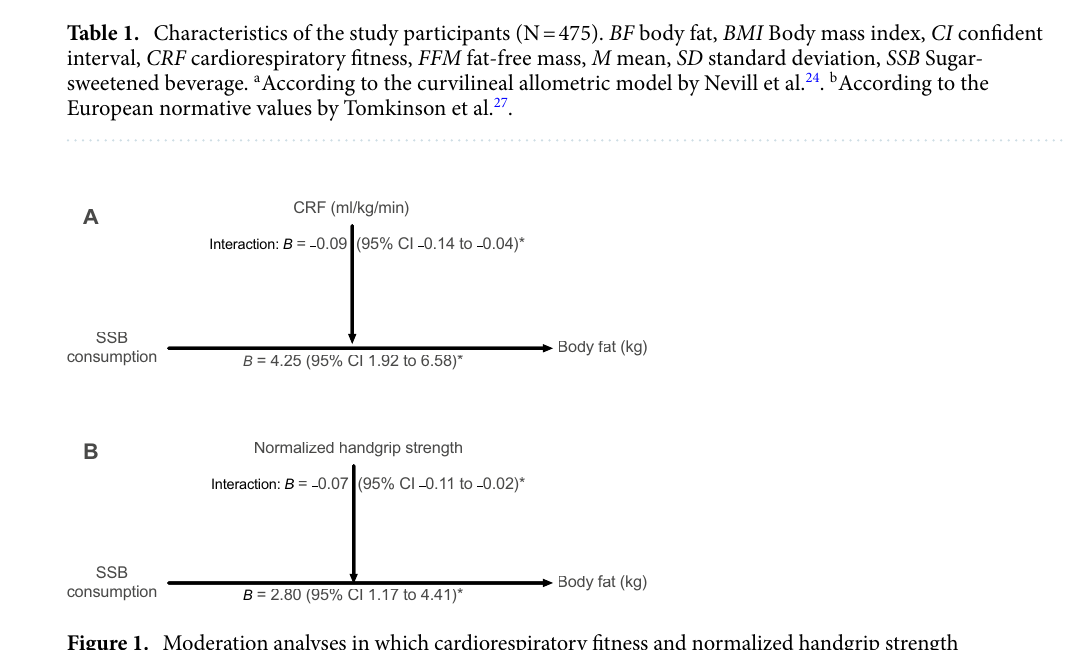
Figure 1. Moderation analyses in which cardiorespiratory fitness and normalized handgrip strength moderate the association between sugar-sweetened beverage consumption and adiposity. Beta presented as unstandardized regression coefficients and 95% confidence interval. Adjusted for sex, age, socioeconomic status, somatic maturity, fat-free mass, fruit consumption, vegetables consumption, and sweets consumption. * p <